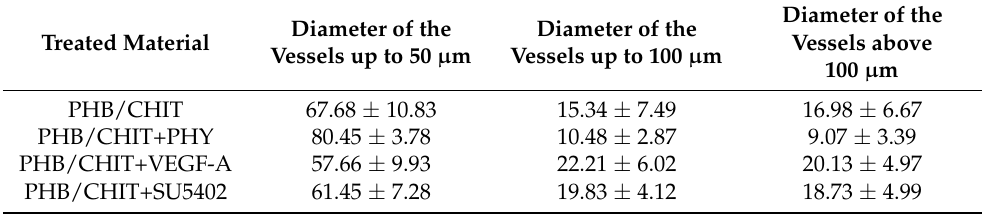
Table 3. Diameter of the vessels of the CAM tissue around the PHB/CHIT depending on the treatment of the scaffold. Data are presented as a mean in % ± SD of n = 3 independent experiments. Experimental groups included n = 6 implants for each